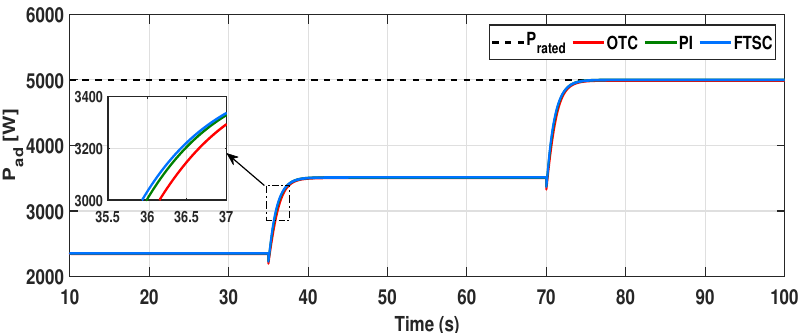
Figure 11. Aerodynamic power captured by the WECS under different control schemes for step wind profile.